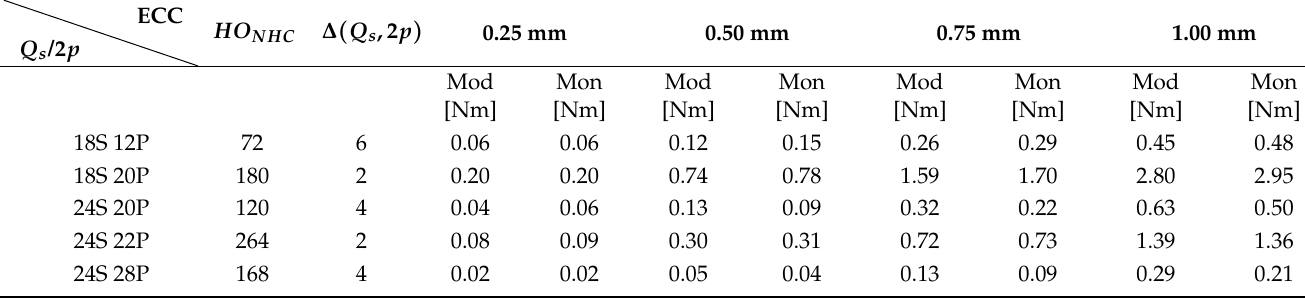
Table 10. Peak-to-peak value of cogging torque AHC of different PMSM and MPMSM slot/pole combinations in the presence of